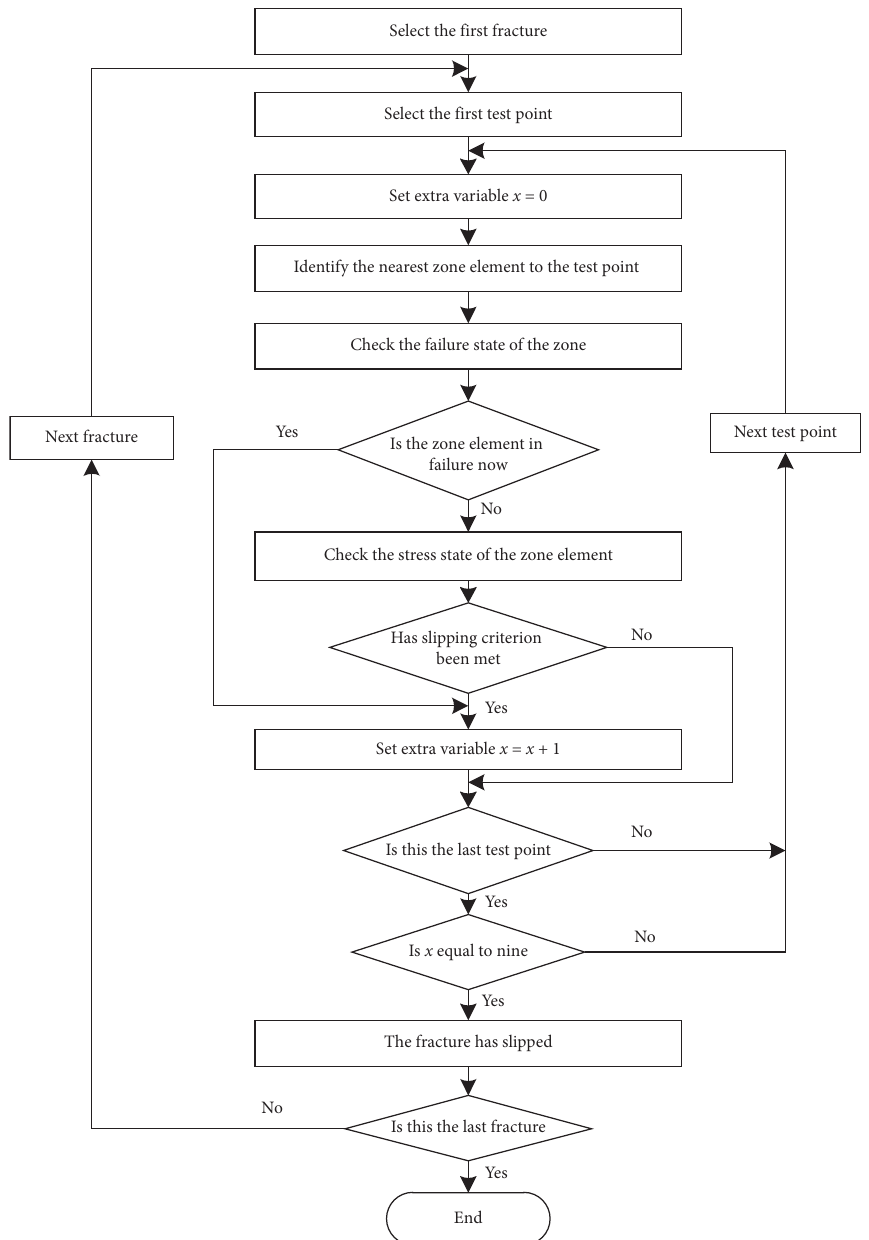
Figure 1: Flow diagram for the evaluation of fracture